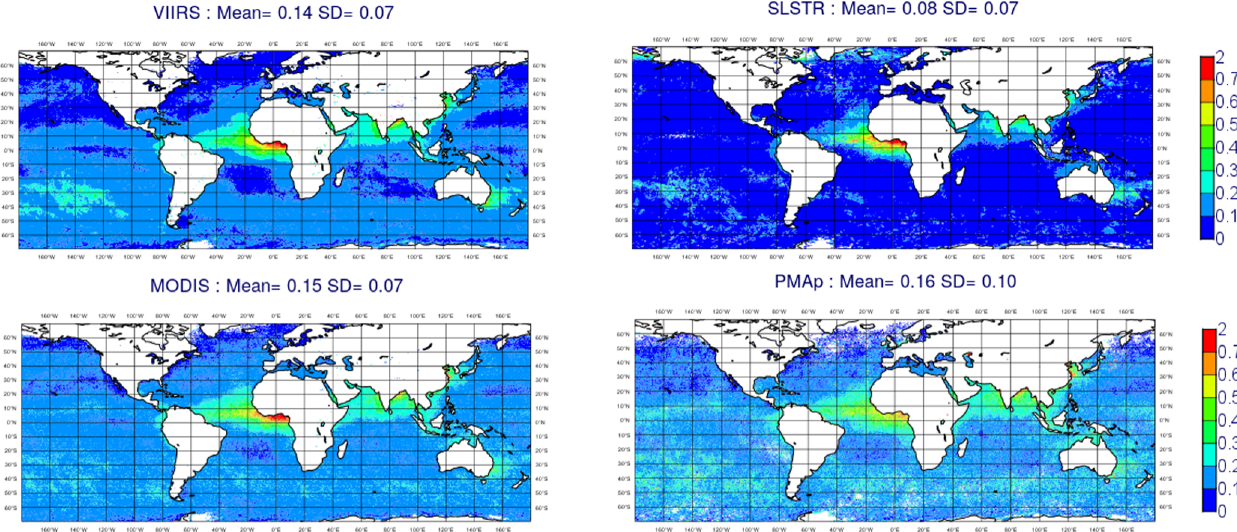
Figure 2. Global maps of temporal mean AOD from Terra and Aqua/MODIS, NOAA20 and SNPP/VIIRS, S3A and S3B/SLSTR, and MetOp-A/B–PMAp for the DJF (2019–2020) period over